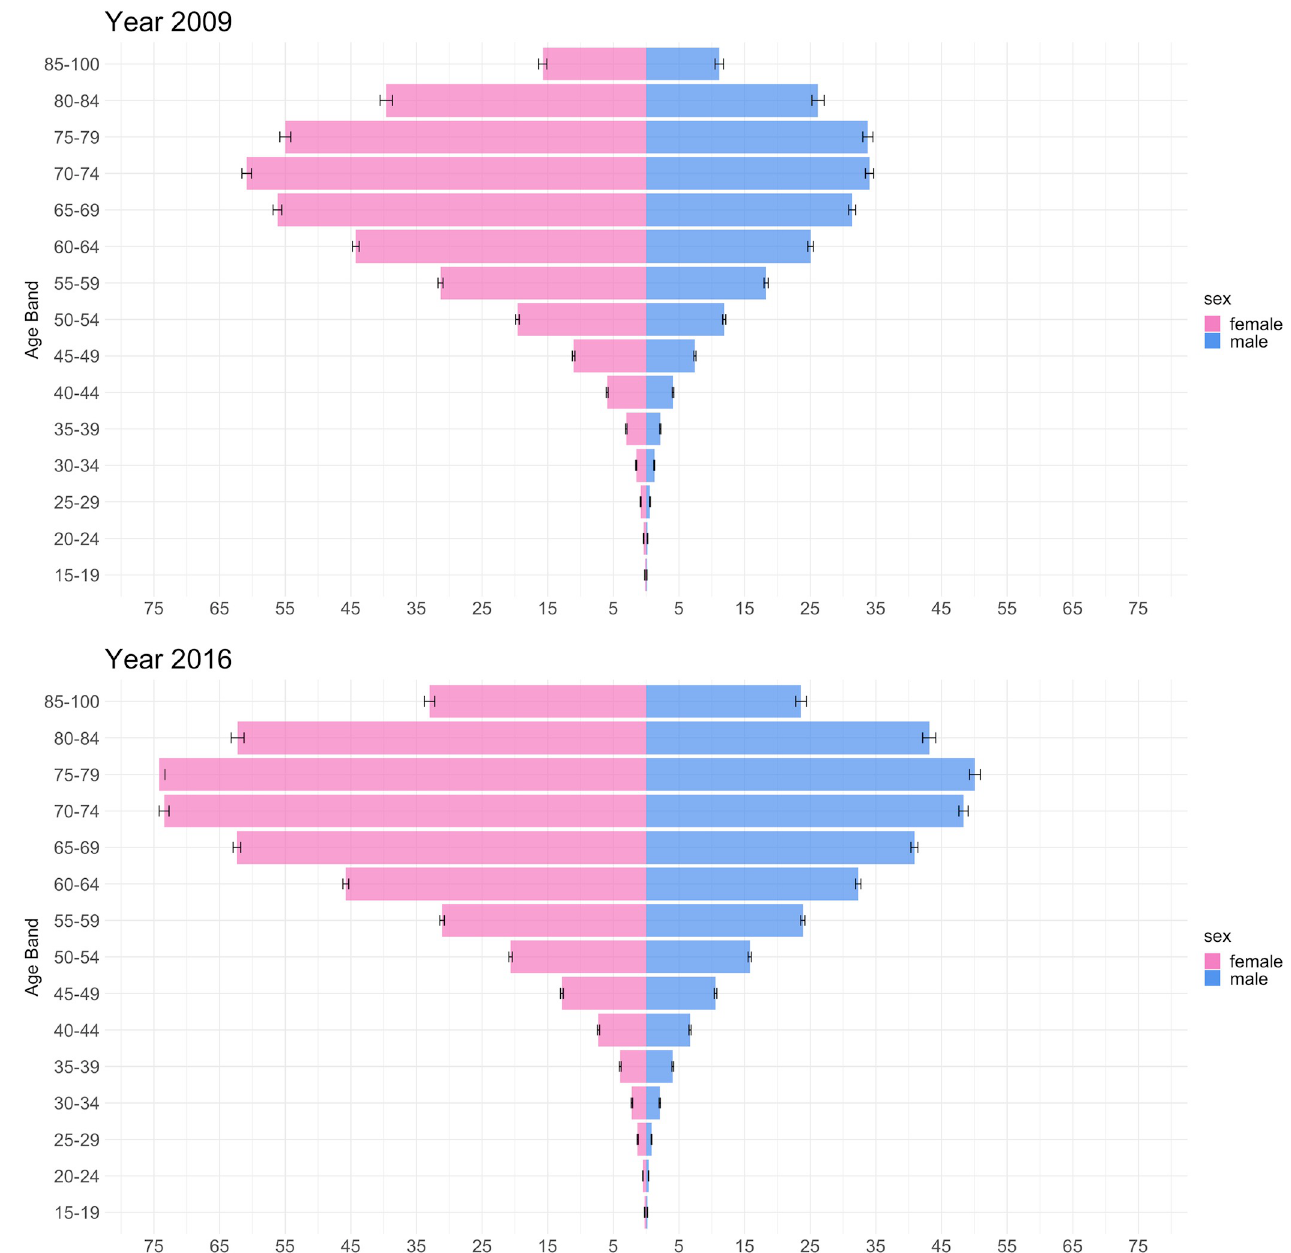
Fig 2. Population pyramids of admitted cases with Type 2 Diabetes Mellitus (T2DM) among the Universal Coverage Scheme patients in Thailand in 2009 and 2016. Note: T2DM crude admission rates are per 1,000 population. The error bars indicate the 99% confidence interval.